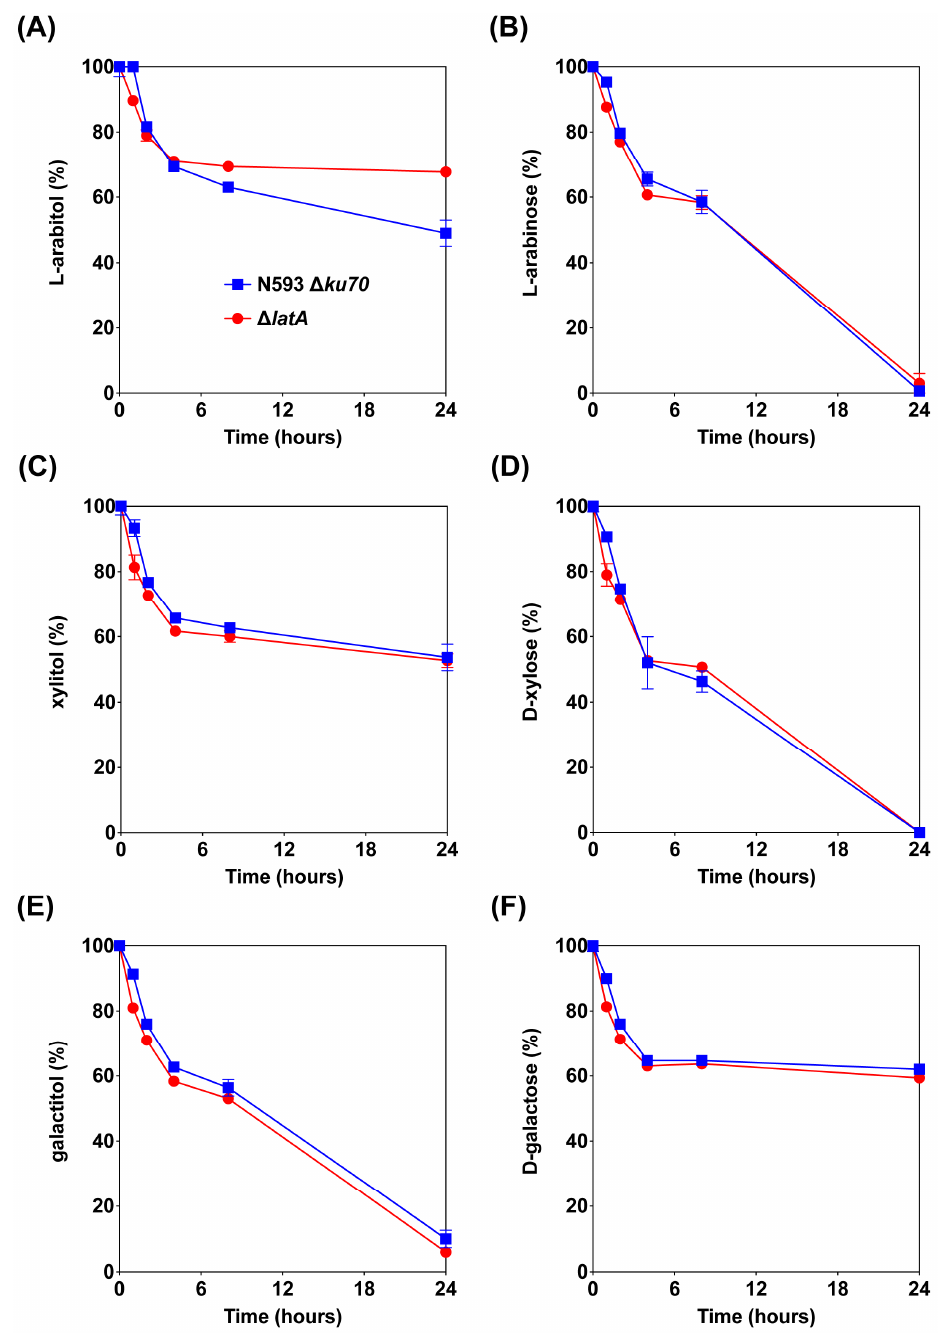
Figure 3. Consumption of sugars and polyols by the A. niger reference strain and ∆ latA in liquid cultures supplemented with L -arabitol ( A ), L -arabinose ( B ), xylitol ( C ), D -xylose ( D ), galactitol ( E ) and D -galactose ( F ) as the substrates. The error bars indicate the standard deviation between biological triplicates.